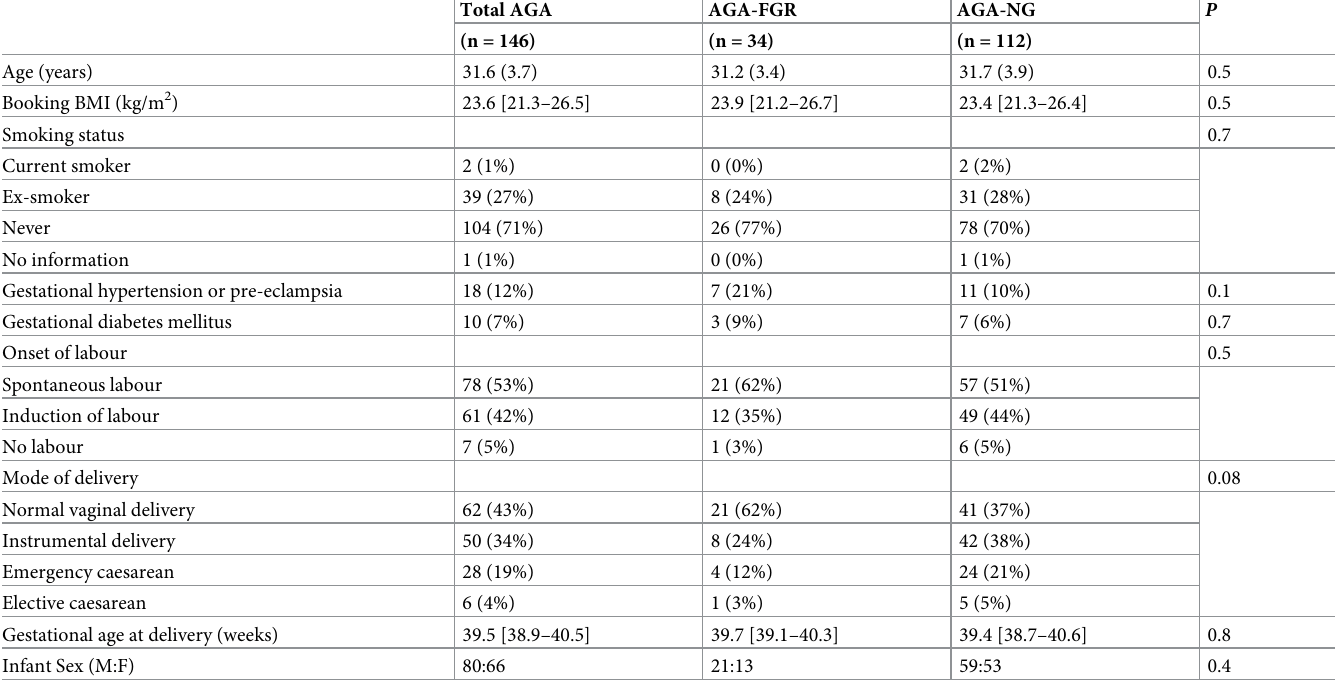
Table 1. Maternal characteristics and delivery outcomes of recruited appropriate-for-gestational-age participants overall and comparison between infants with low- and normal-antenatal growth